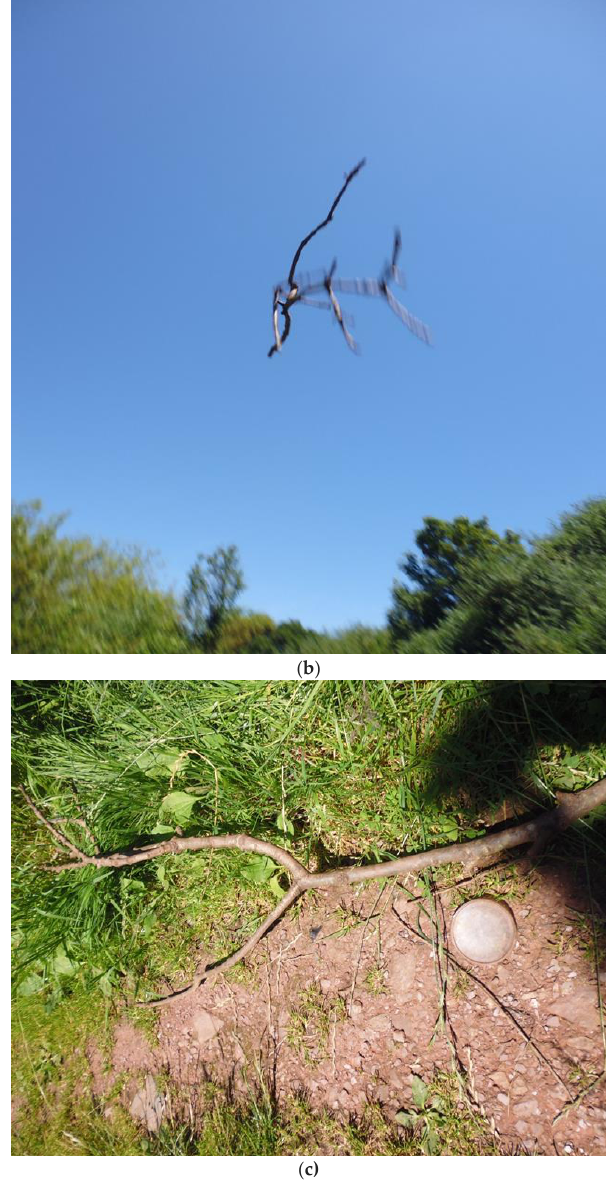
Figure 8. ( a ) Soil residue; ( b ) Stick in air; ( c ) Stick and plastic lid exchange.